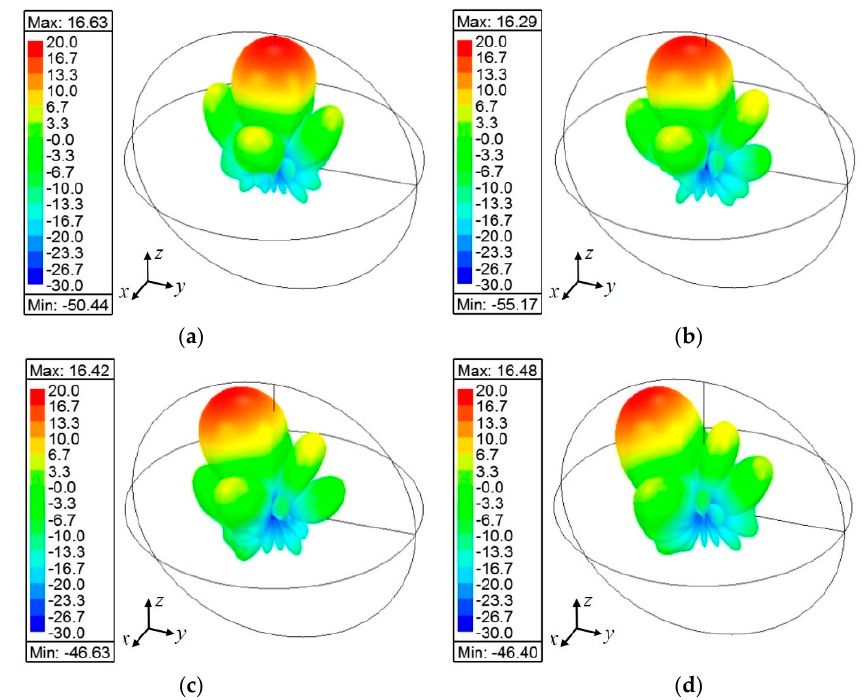
Figure 10. Simulated radiation patterns of the 4 × 4 patch antenna array when input phase offsets are (a) 0°, (b) 45°, (c) 90°, and (d) 135°.